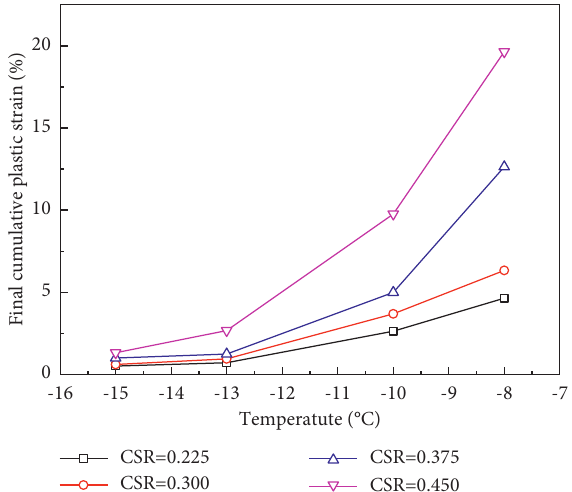
Figure 8: Relationship between the final cumulative plastic strain ( ε